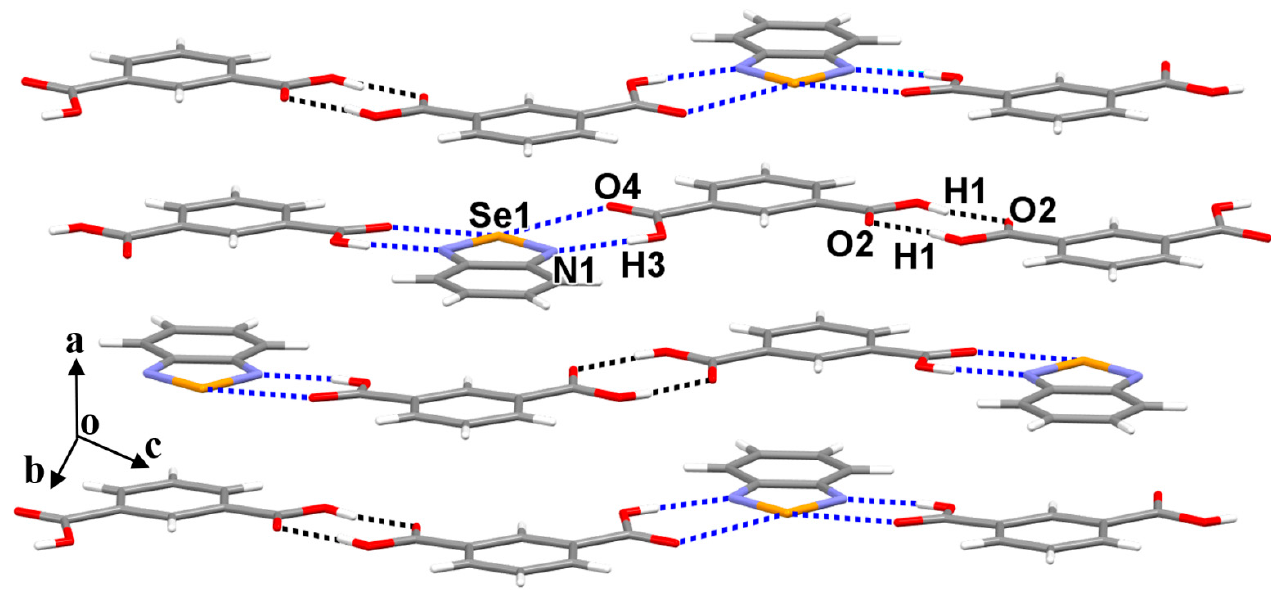
Figure 4. Part of the crystal structure of cocrystal 2 showing the O–H···O hydrogen bonds, O–H···N hydrogen bonds, N–Se···O chalcogen bonds and π ··· π stacking interactions.